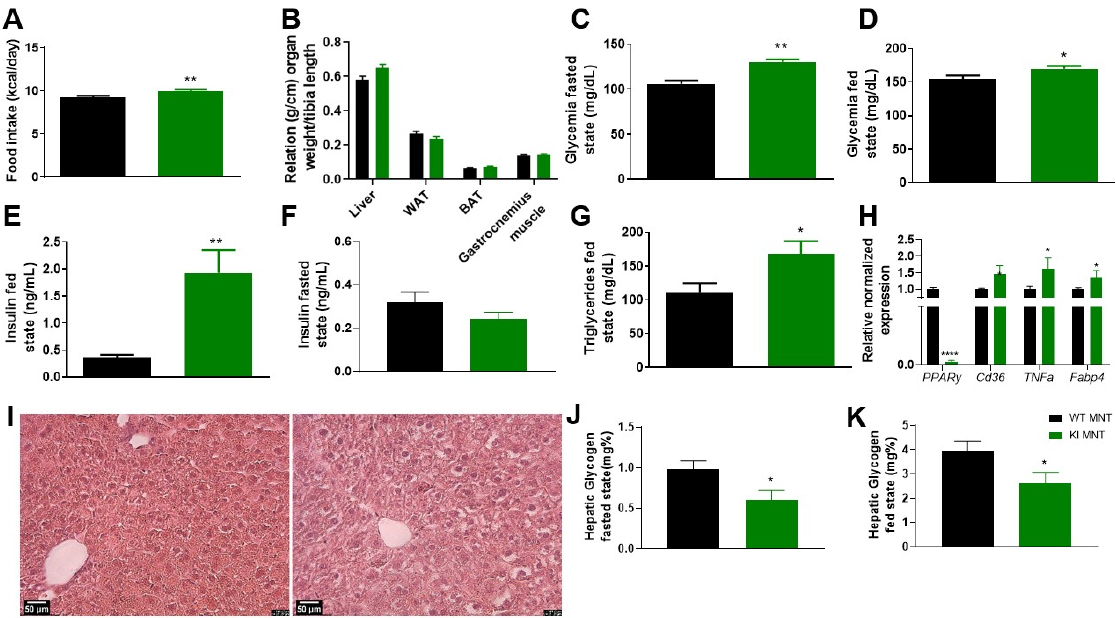
Figure 2. KI S273A lineage after 8 weeks of maintenance diet (MNT), since weaning, comparing with WT animals. ( A ) Food intake during the 8 weeks of MNT diet. ( B ) Relation of organ weight/tibia length on euthanasia day. Glycemia on ( C ) fasted and ( D ) fed states, on euthanasia day. Plasma insulin levels on ( E ) fed and ( F ) fasted states on euthanasia day. ( G ) Plasma triglycerides in fed state. ( H ) Relative normalized expression of PPAR γ , Cd36 , TNF α , and Fabp4 on liver, data were normalized to the expression of reference genes: 36b4 and Rpl27 . ( I ) Liver representative image. ( J ) Hepatic glycogen in fasted and ( K ) fed states. Data are represented as mean ± SEM. Statistical analysis was performed using non-parametric t -test. * p < 0.05, ** p < 0.01, **** p < 0.0001. n ≥ 5 per group. As expected, lean wild-type animals did not present phosphorylation at PPAR γ